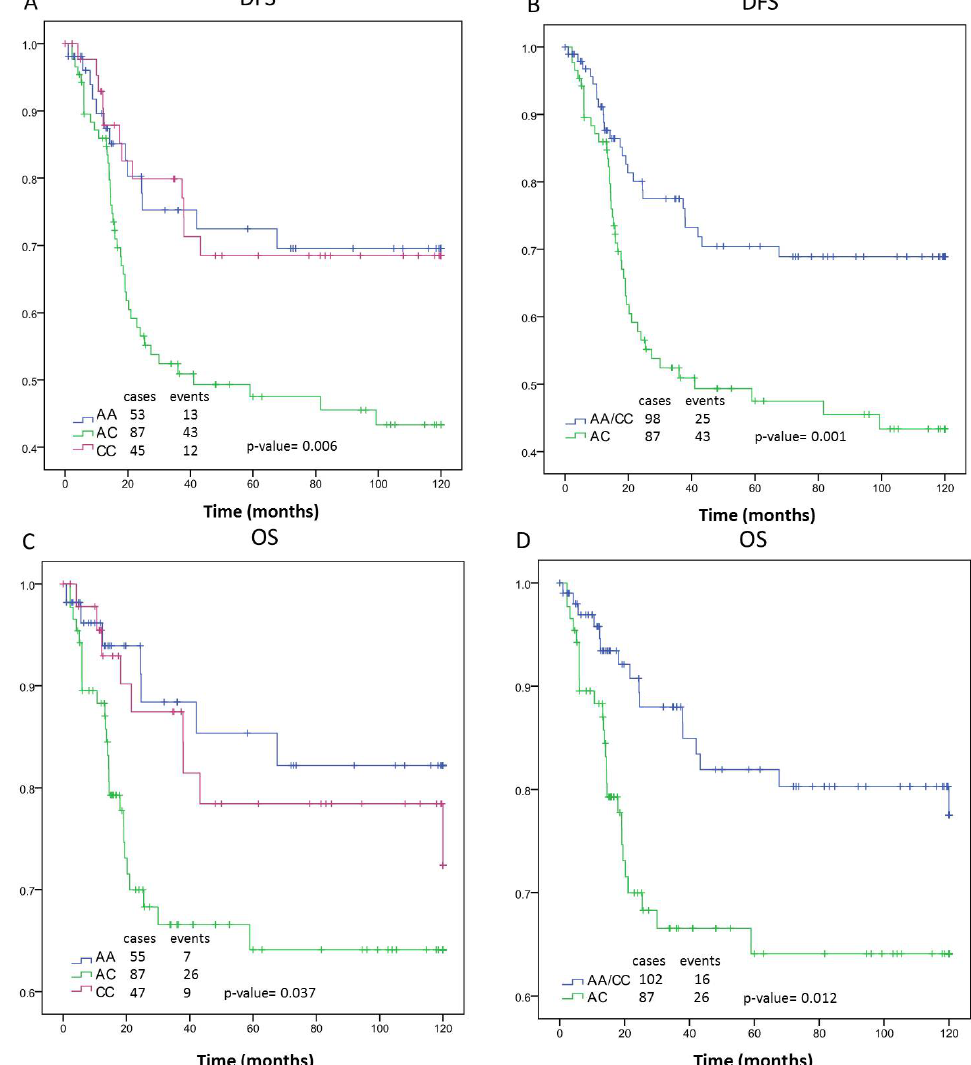
Figure 3. Kaplan- Meier curves of rs3736729 showing disease-free survival (DFS) overall survival (OS) of estrogen receptor negative (ER − ) breast cancer patients. A and C : rs3736729 genotypes A/A, A/C and C/C; B and D : rs3736729 genotypes A/A and C/C vs. A/C; A and B : DFS; C and D :